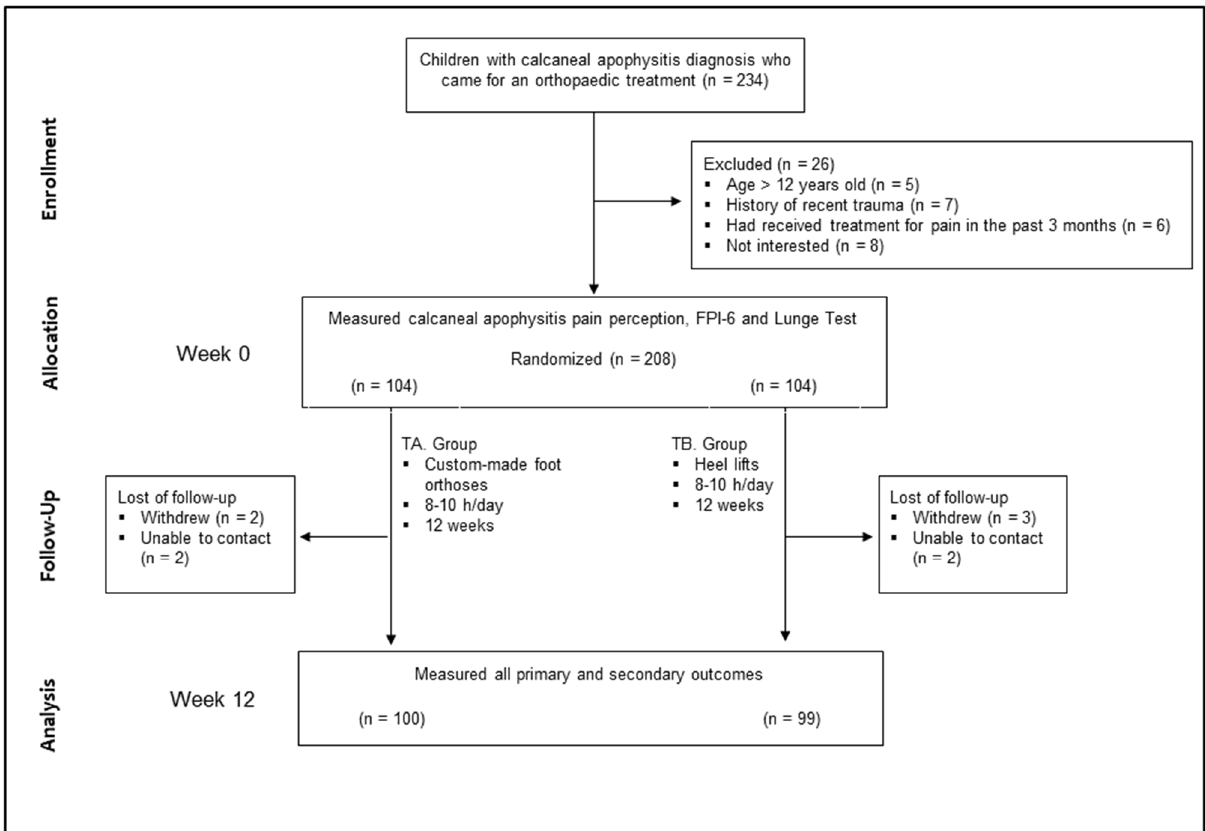
Figure 3. Design and flow of the children through the trial. TA = treatment A group; TB = treatment B group; FPI = Foot Posture Index.